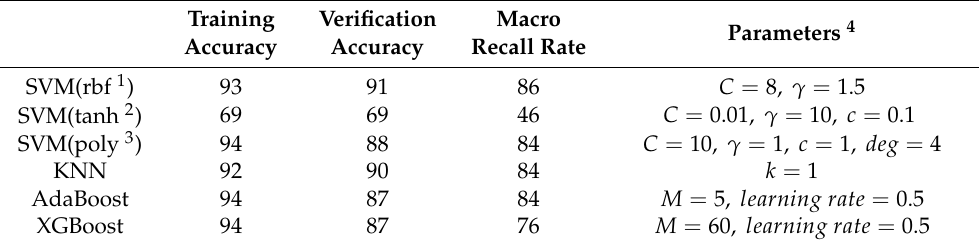
Table 3. Results of mesh search tuning for SVM models.